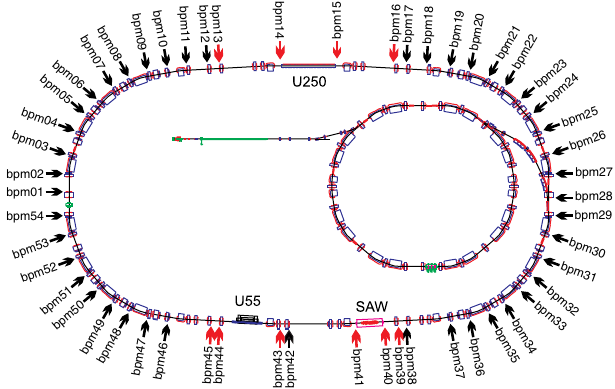
FIG. 2. Map of the DELTA synchrotron radiation facility, consisting of a linac, a full-energy synchrotron, and a storage ring with 54 BPMs installed (black and red arrows). Ten of them (red arrows) are capable of taking multiturn data at a sampling rate equal to the revolution frequency. For the measurements presented here, the U250 (drift) section between BPM 14 and BPM 15 is